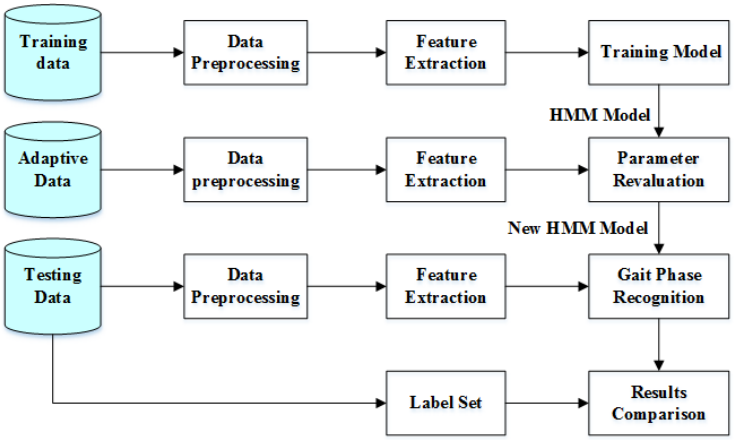
Figure 8. Flow chart of adaptive algorithm based on model